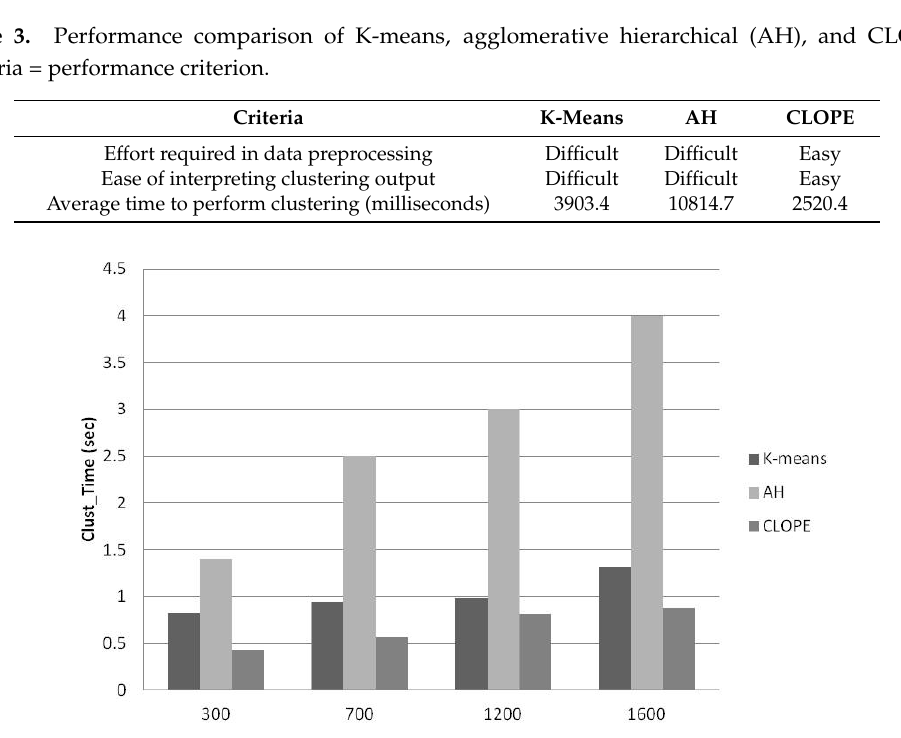
Figure 2. Comparison of clustering time of K-means, AH, and CLOPE, averaged over 5 runs.